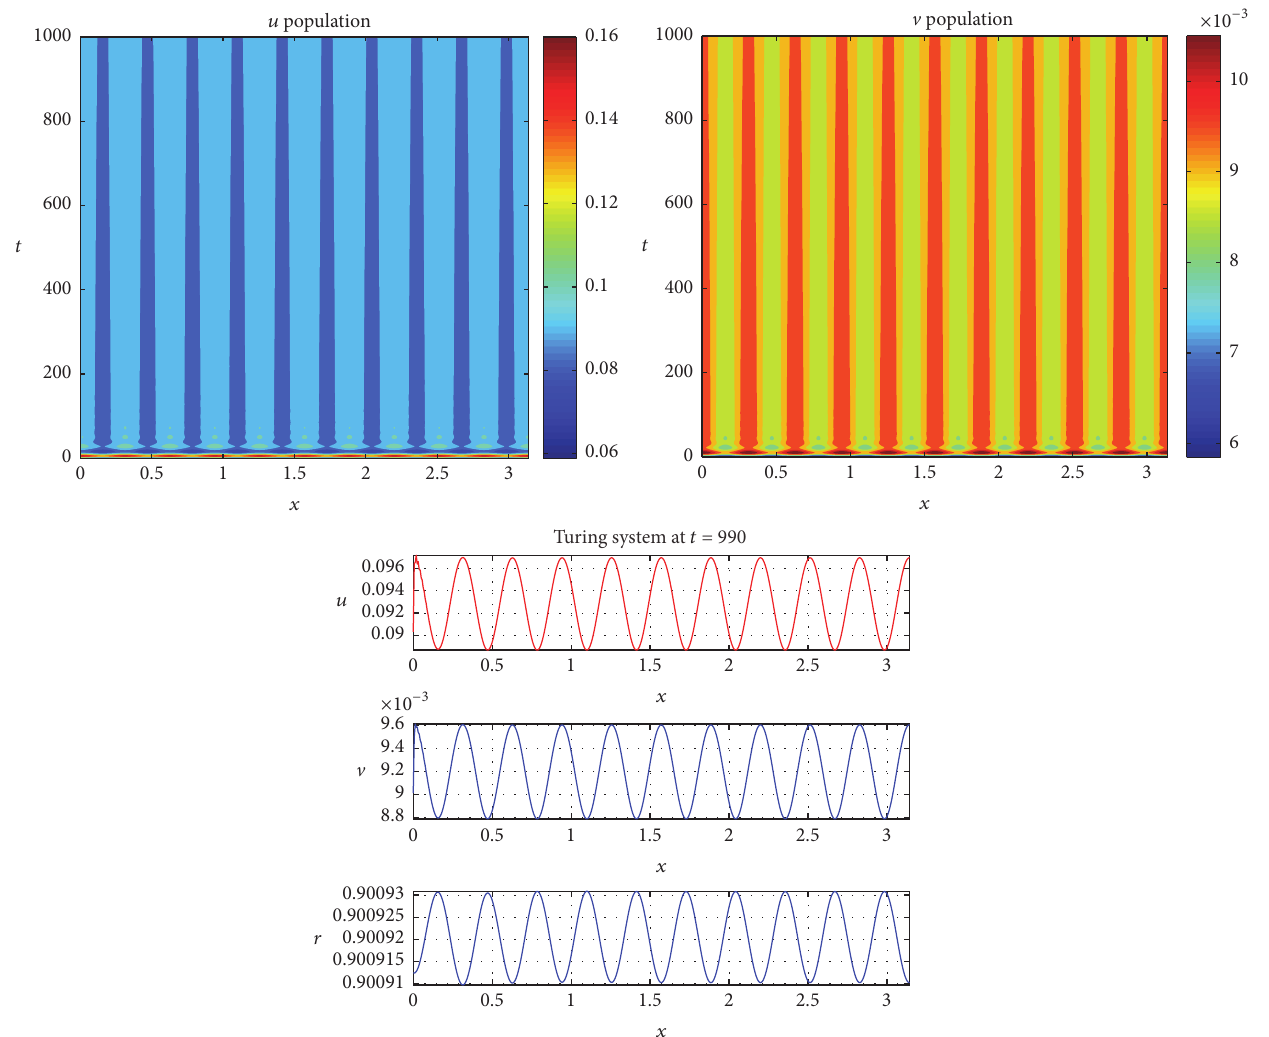
Figure1:HerewedemonstratethatcannibalismcanindeedinduceTuringinstabilityin(8)–(10).WeseeaspatialTuringpatterninthejuvenile species in the left panel. The right panel shows the spatial profile of all three species, after the simulation is run much longer ( 𝑡 = 1000 ). We see Turing persists in both the adult and juvenile predators, but the prey has very weak Turing. The values of the parameters here are 𝑑 1 = 10 −11 , = 1.7 × 10 −8 , 𝑑 = 0.9 , 𝑟 = 0.01 , 𝑚 = 0.1 , 𝛾 = 0.01 , 𝑠 = 0.01 , 𝑢 = 0.13 , 𝑡 𝑑 2 3 = 0.005850 , 𝑟 1 = 1.162736 V 1 ∗ ∗